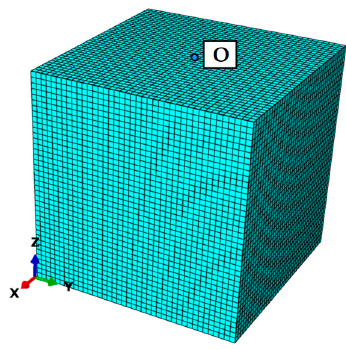
Figure 4. Finite element model of the cube.